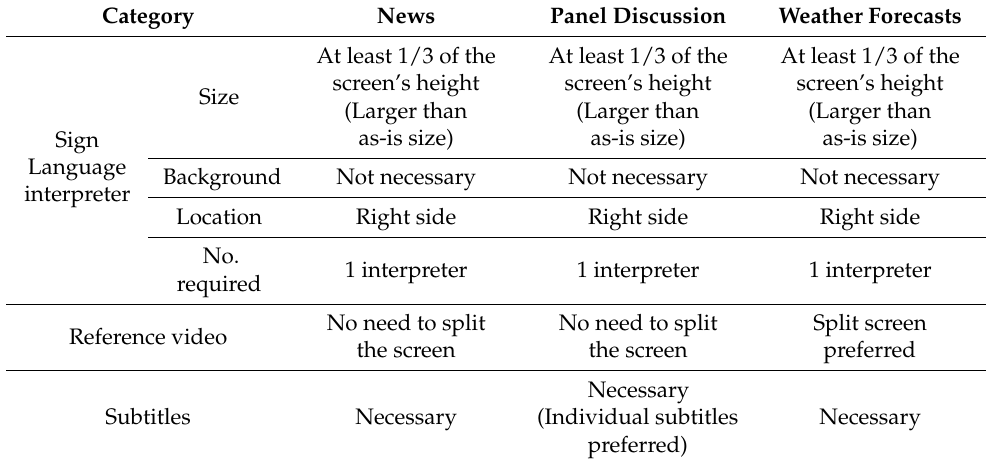
Table 10. Basic conditions for information delivery component layout design for DHH individuals.